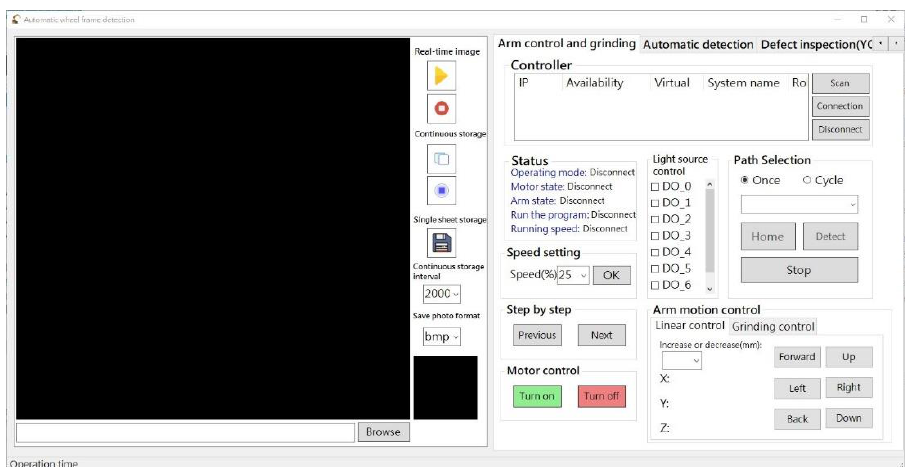
Figure 7. Basic control interface.